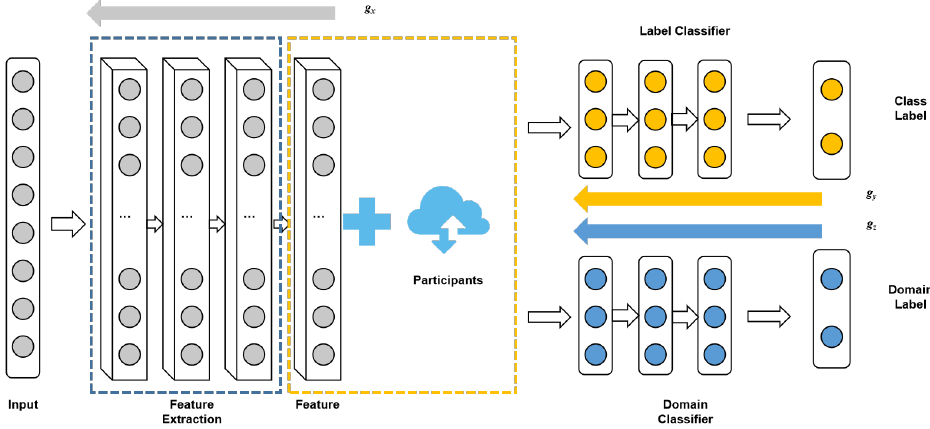
Figure 1. Structure diagram of a neural network in the